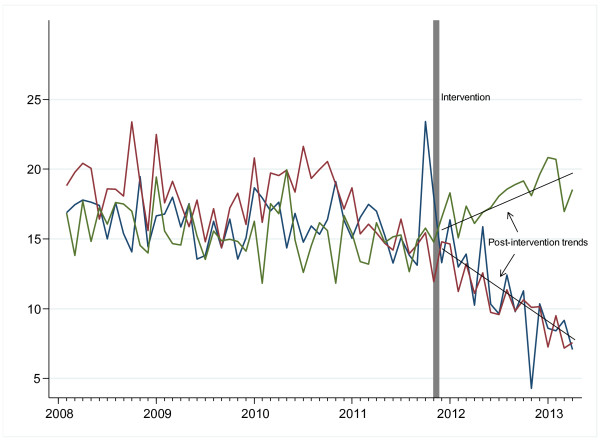
Trends in the monthly antibiotic use density (expressed as RDD per 100 patient days) for cephalosporins (blue). Fluoroquinolones (red) and penicillins (green) in the medical service pre- and post-intervention.